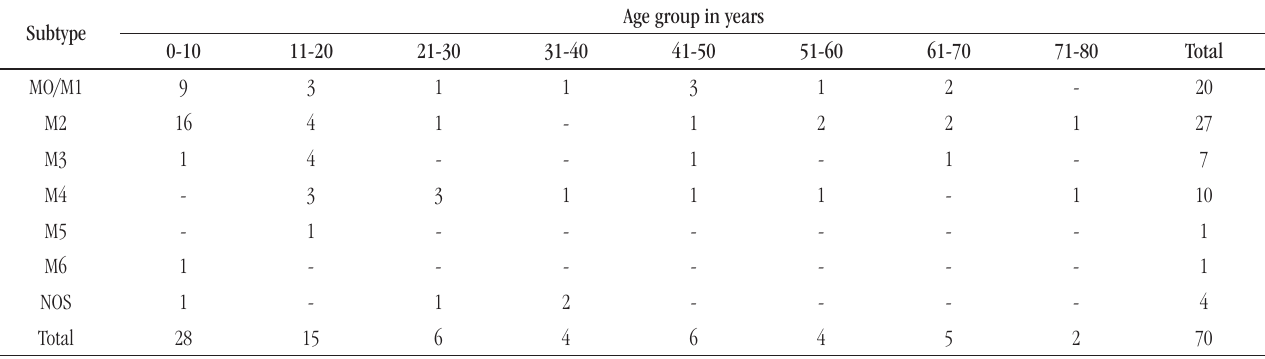
taBLE 1 – AML subtypes according to age